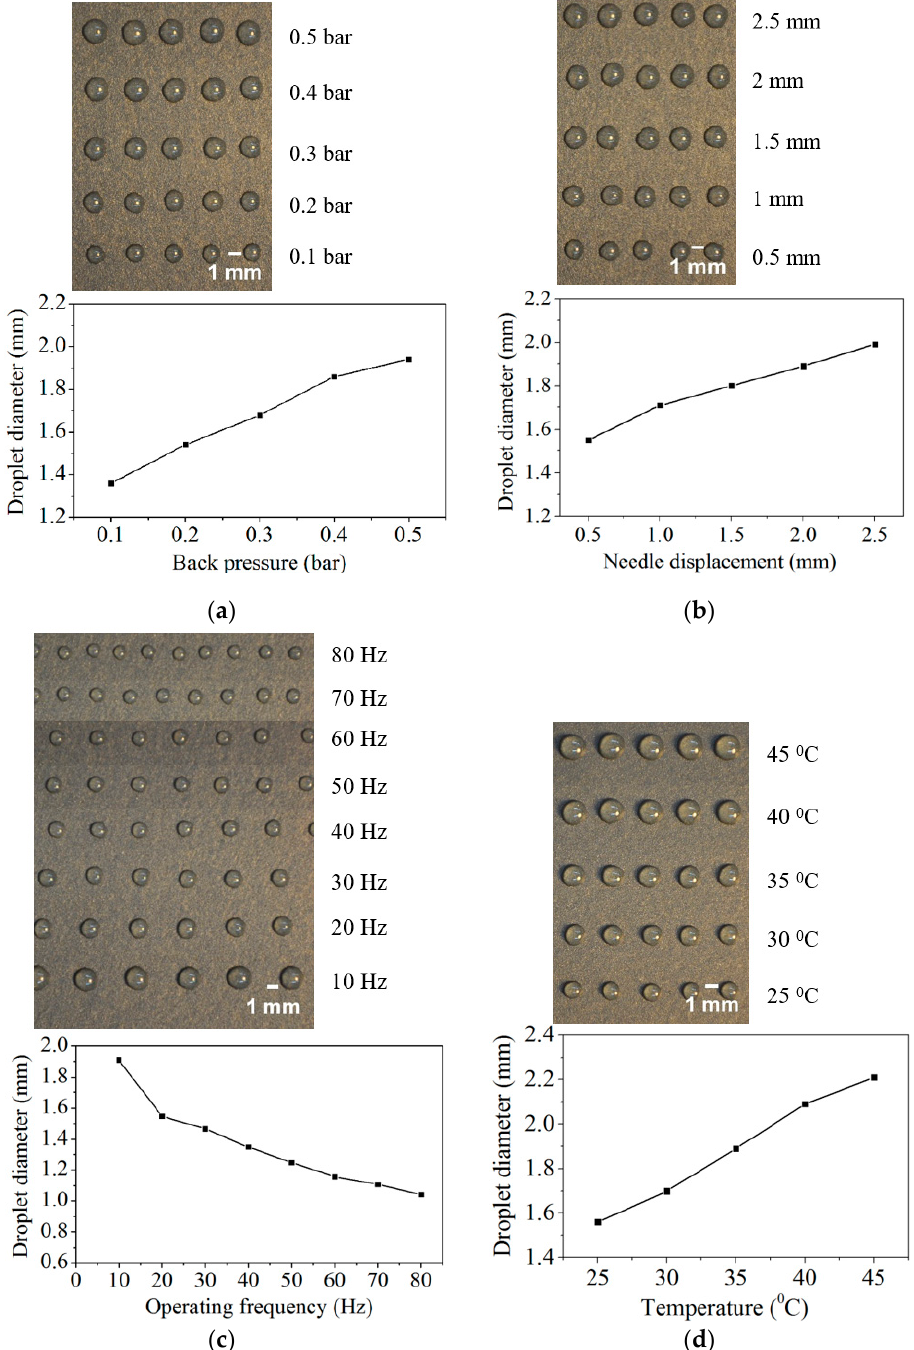
Figure 10. Experimental results for the droplet diameters. ( a ) Backpressure effect; ( b ) needle placement effect; ( c ) operating frequency effect; and ( d ) fluid temperature effect.